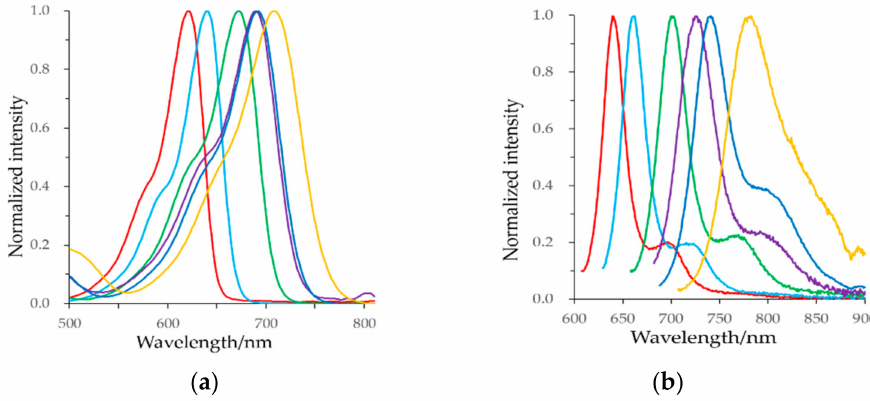
Figure 2. Normalized absorption ( a ) and fluorescence (uncorrected) ( b ) spectra of BODIPYs 1 – 6 in dichloromethane (DCM) (red, 1 ; light blue, 2 ; green, 3 ; purple, 4 ; blue, 5 ; and yellow, 6 ,